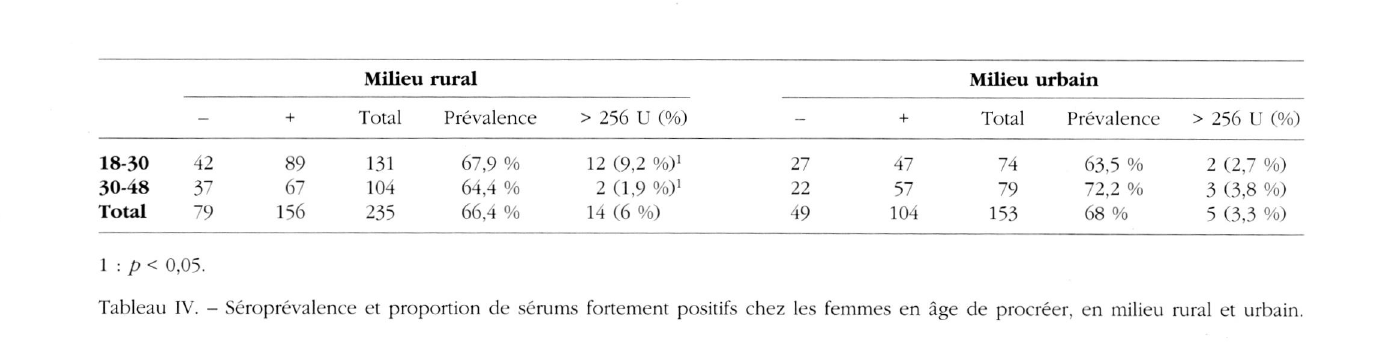
Tableau IV. - Séroprévalence et proportion de sérums fortement positifs chez les femmes en âge de procréer, en milieu rural et urbain.